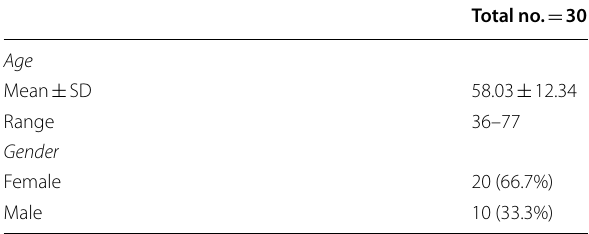
Table 1 Demographic data of the studied patients Table 2 Pathological results and treatment of the studied